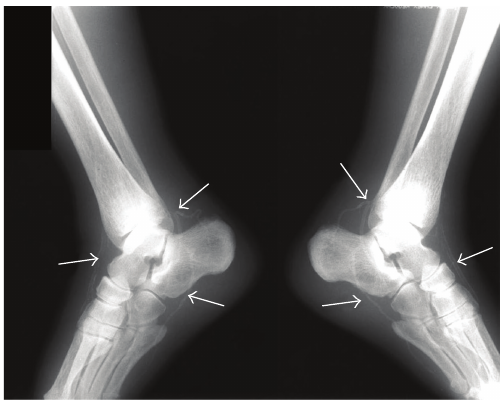
Figure 2: Ankle radiographies show anterior and posterior tibial arterial wall calcifications (arrows).